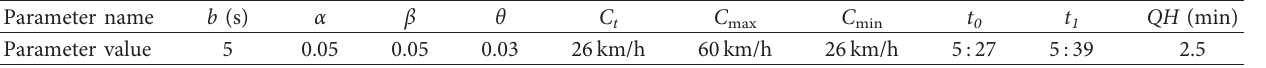
Table 3: Basic parameters of coordinated control strategy simulation.